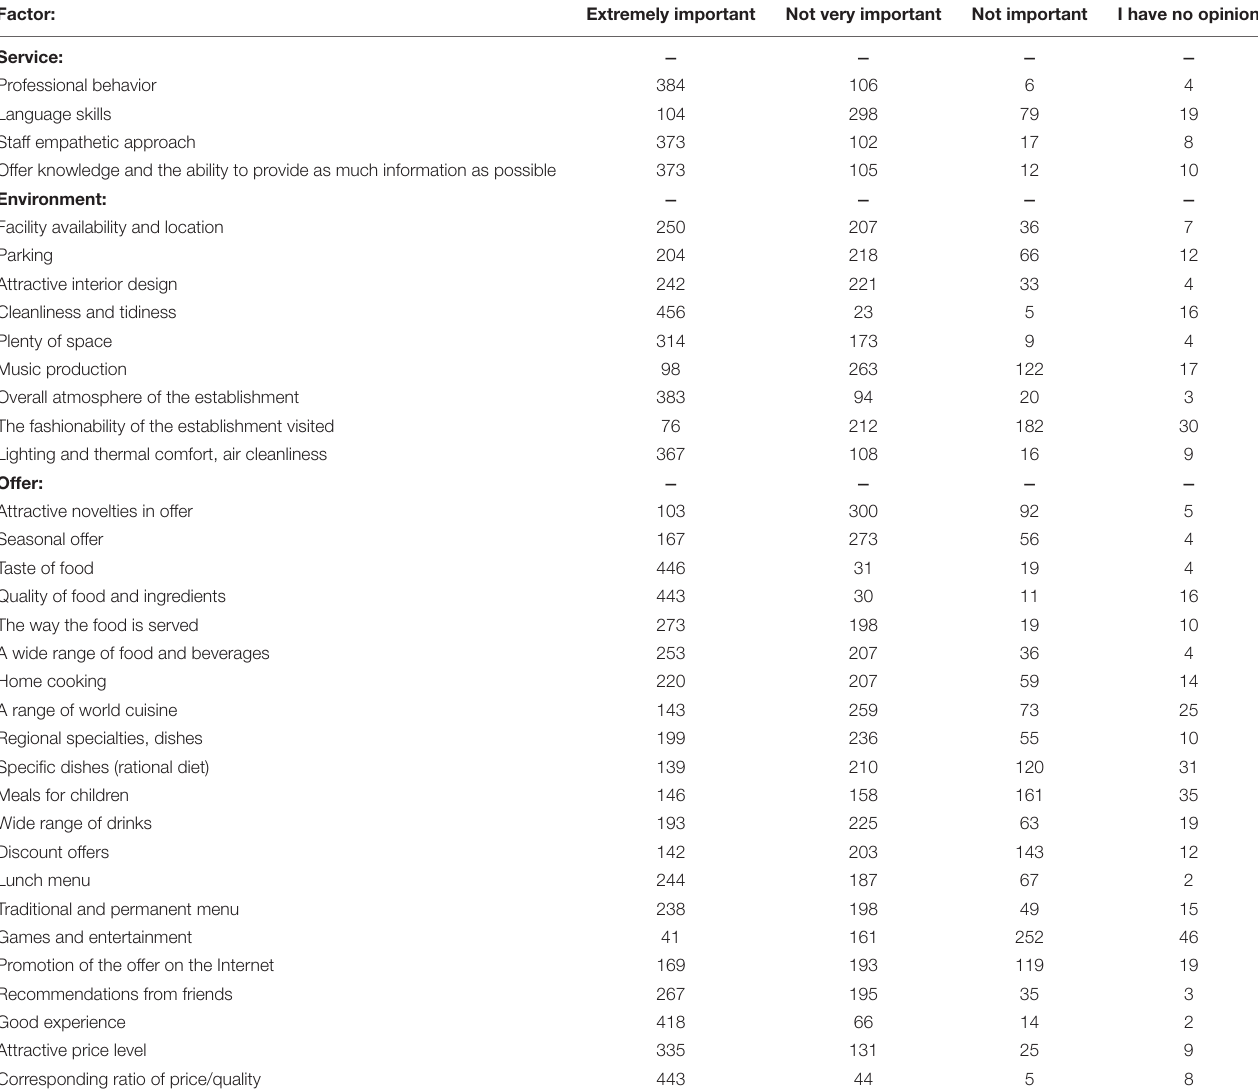
TABLE 1 | Significant factors influencing repeat visits to selected international tourism enterprises based on the responses of customers in Czechia. Factor: Extremely important Not very important Not